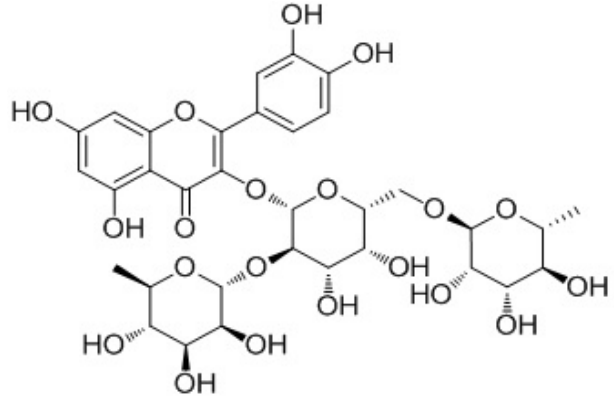
FIGURE 1 - Structure of